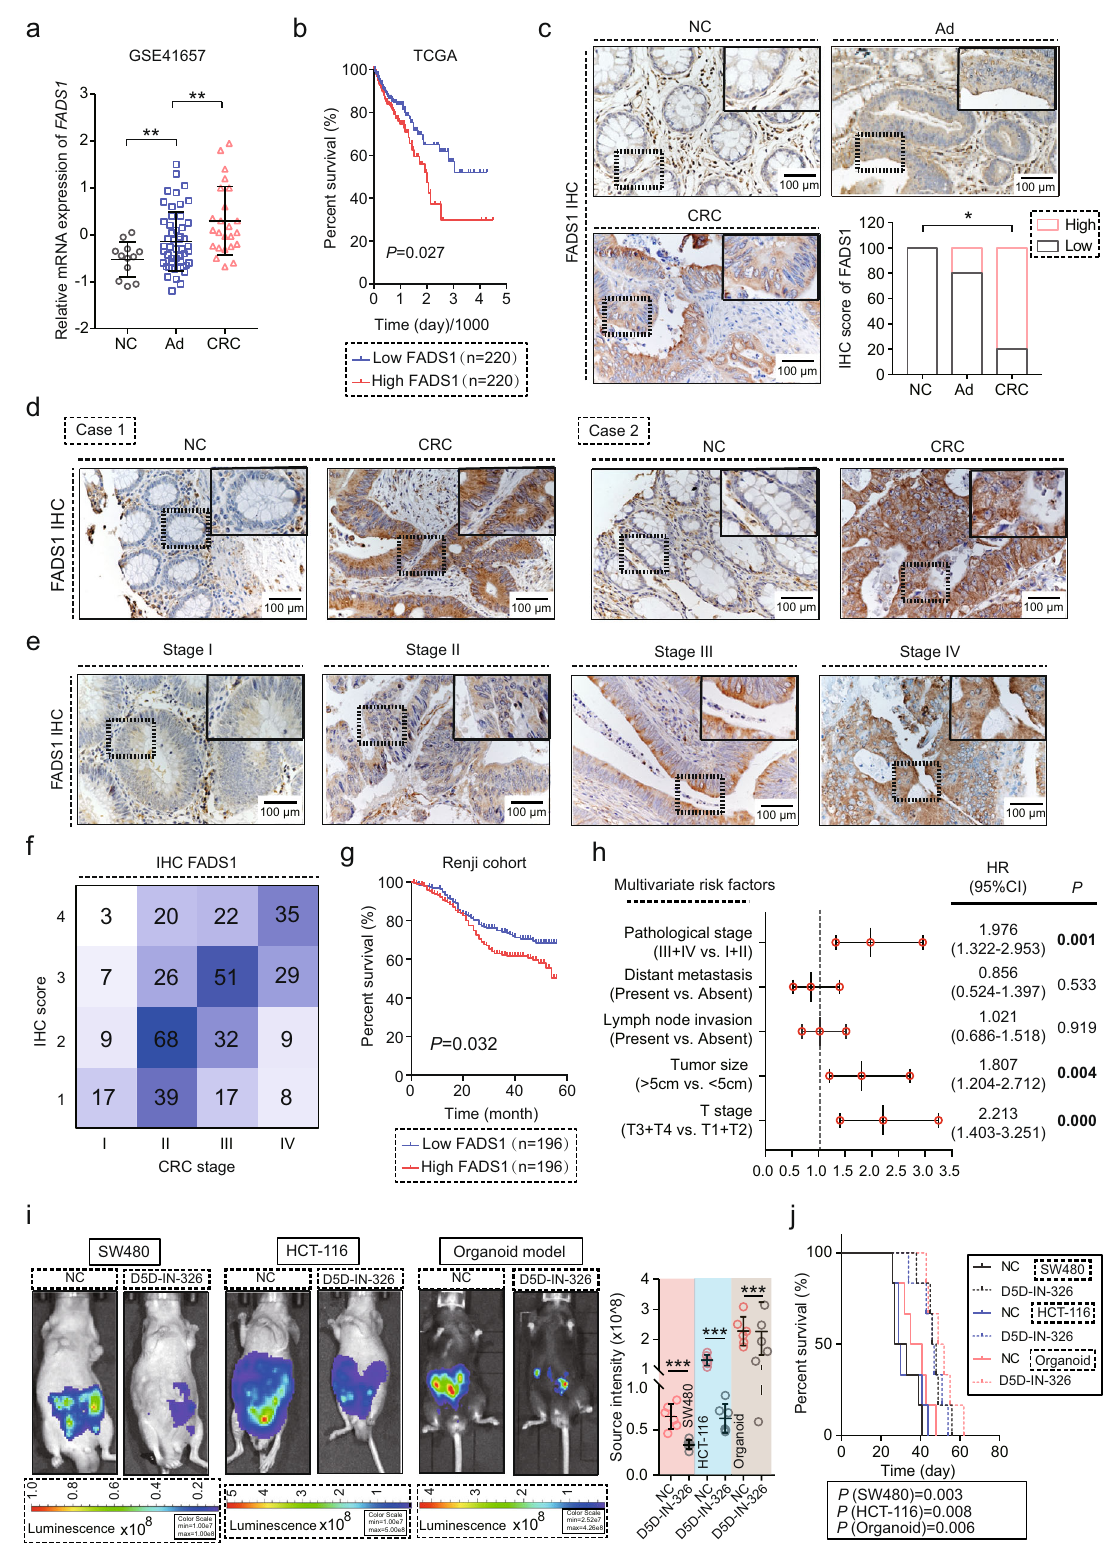
assistance of MYD88, extracellular signals further activate nuclear factor- κ B (NF- κ B) and mitogen-activated protein kinase cascades, leading to the transcription of in fl ammation-related target genes 48 . The TLR4/MYD88-NF- κ B pathway is involved in PTGS2 gene tran- scription that promotes the conversion of AA to PGE2 49 . PTGES